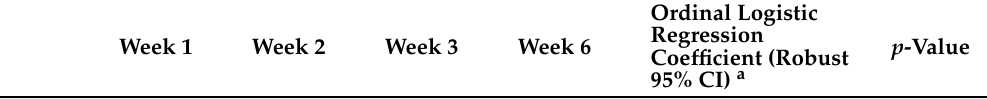
Table 4. Perception ratings by (1) participants with dementia/cognitive impairment, (2) informal carers and (3) study physiotherapists on the safety and appropriateness of gait aid use at week 1 (first training session), week 2 (second training session), week 3 (third training session), and week 6 (fourth and last training